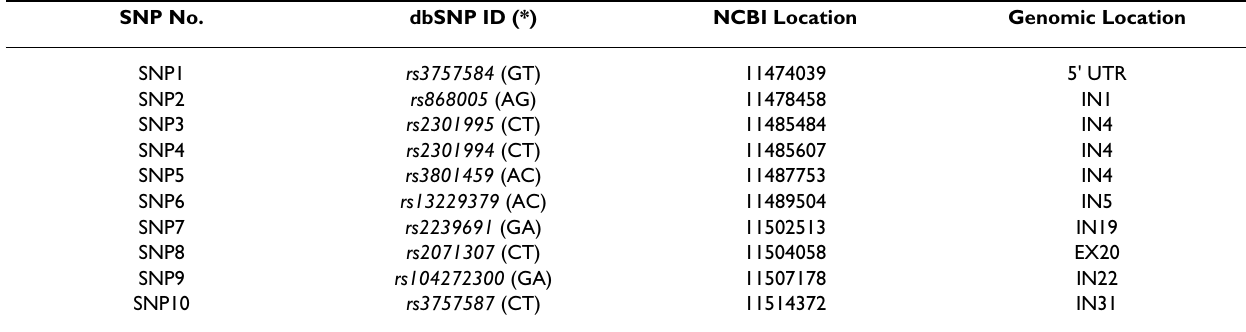
Table 2: Distribution of the studied SNPs in the ELN gene SNP